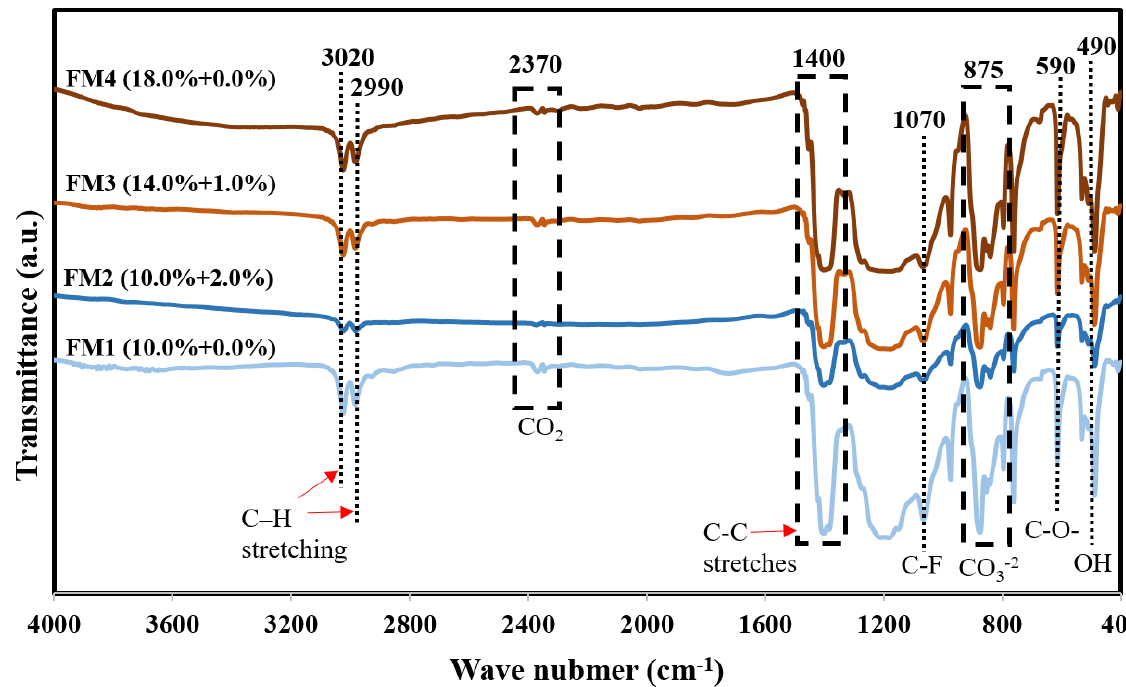
Figure 8. FTIR spectra for PVDF-PAC membranes with different concentrations.